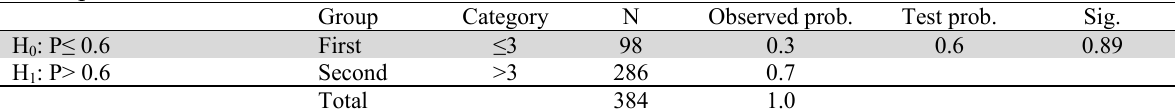
Sales promotion